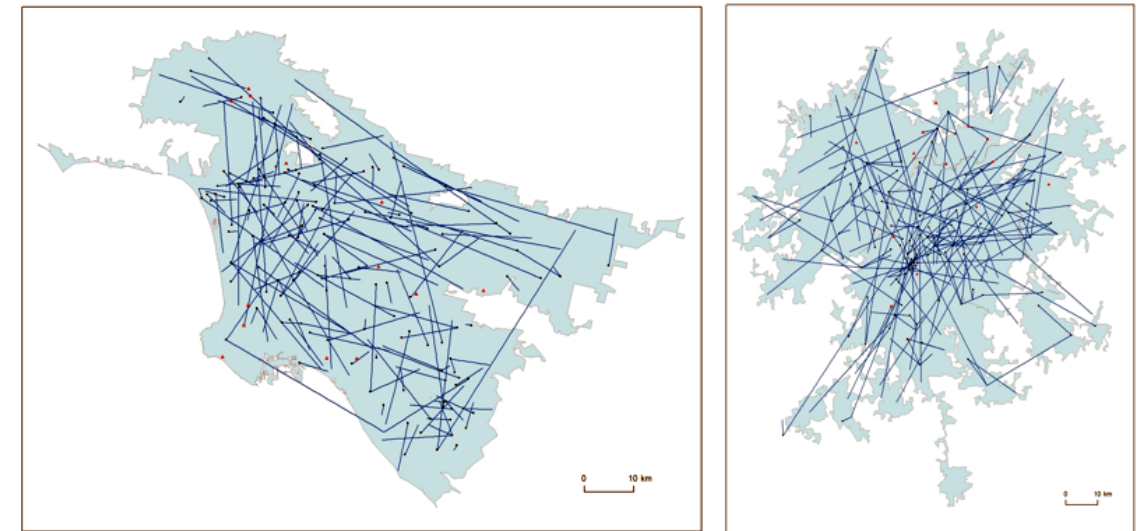
Figure 2. Los Angeles (left) and Atlanta (right) are integrated metropolitan labor markets: People live everywhere and work everywhere. Source: Angel & Blei,